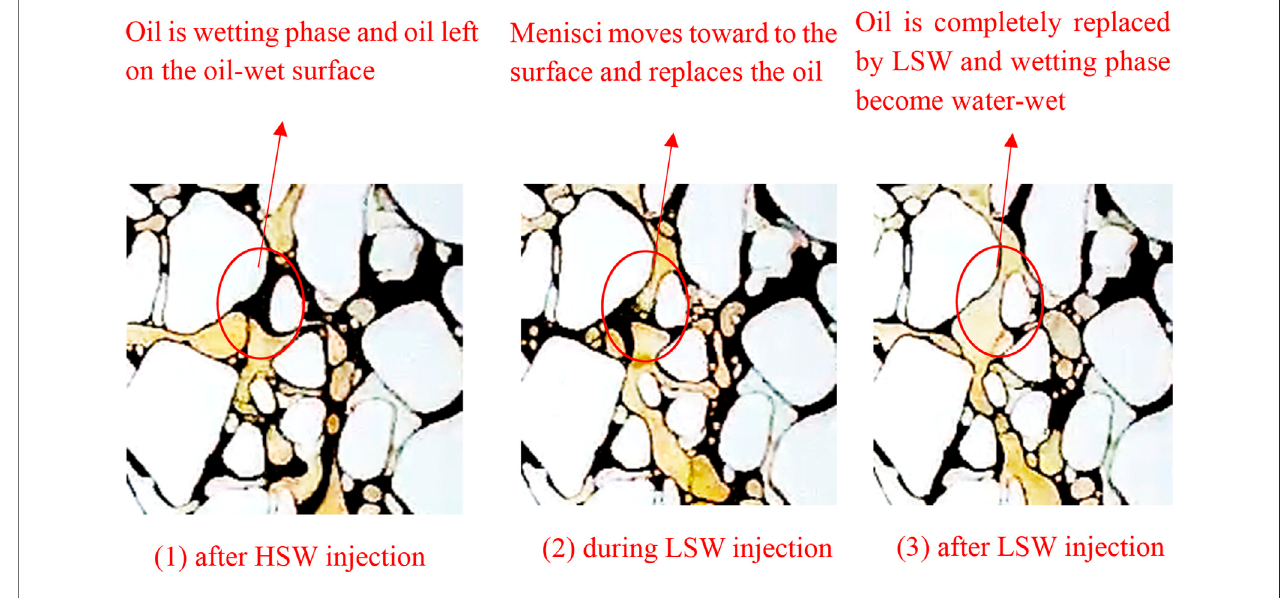
FIGURE 5 | Kaolinite coated micromodel during